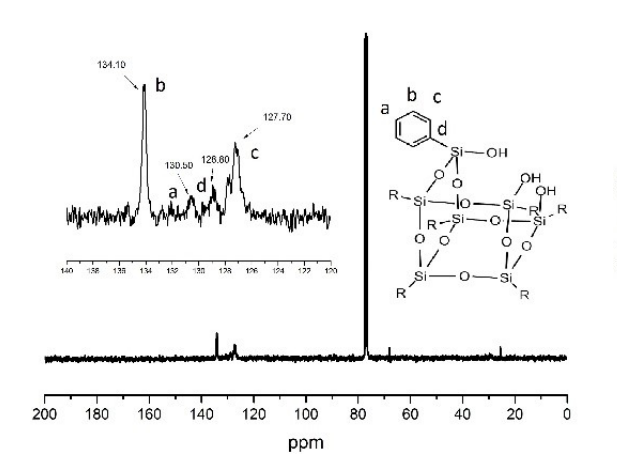
Figure 6: 13 C NMR spectrum of heptamertic phenyl silsesquioxane trisilanol(POSS-triol)